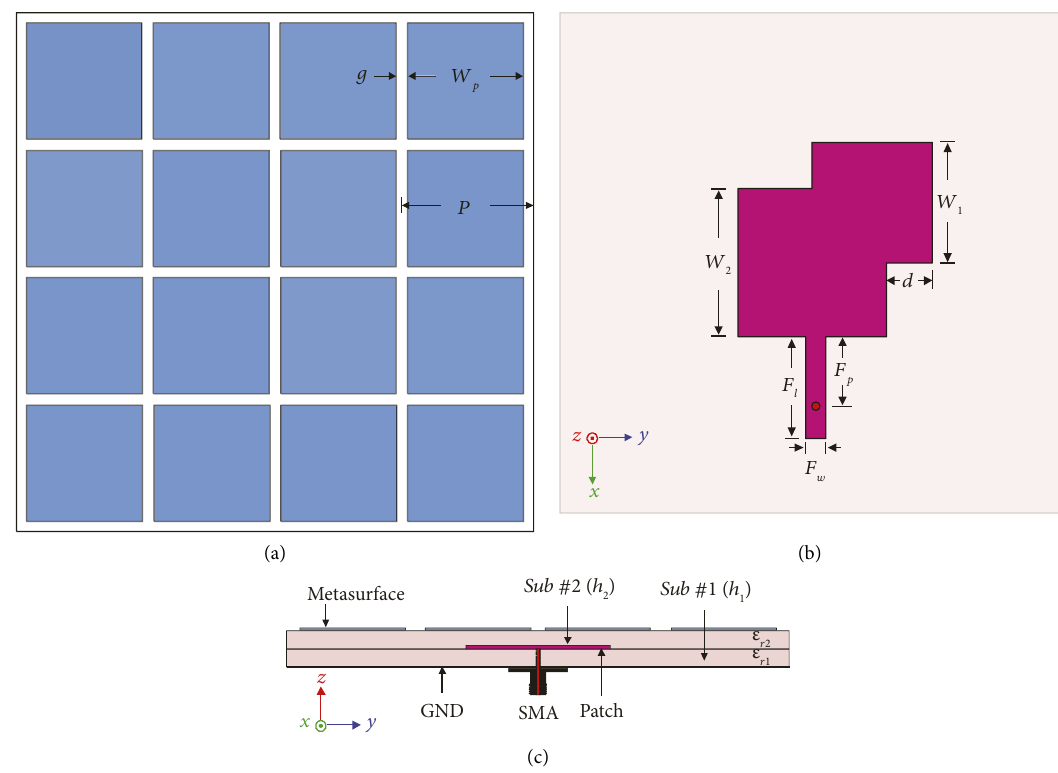
Figure 1: Geometry of the proposed antenna: (a) top view, (b) top view of driven patch, and (c) side